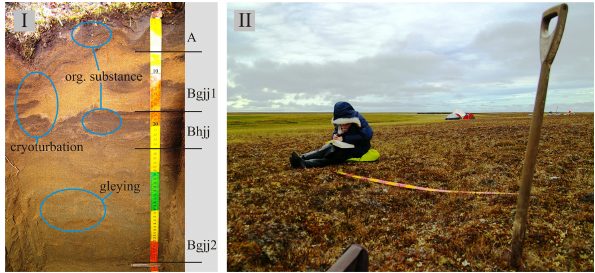
Figure 4. A “sand-dominated and cryoturbated” permafrost- affected soil, Typic Psammoturbel (I) and the study area it is from (II) the Arga Complex, northwestern Lena River Delta, Siberia 2009. Psammoturbel , great group: Psamm(o) from psamm , mean- ing sand; suborder: turb , from Latin turbatio , meaning disturbance; order: el , formative element of Gelisols, from Latin gelu , meaning frost, coldness. “A” and “B” indicate soil horizons. “A” indicates a mineral horizon that has formed at the surface or below an or- ganic horizon. It has accumulated humified organic matter that is mixed with the mineral fraction. “B” indicates subsurface horizons (see Fig. 3). Within this profile there are several B horizons with dif- ferent properties. The suffix “h” indicates an illuvial accumulation of organic matter or sesquioxides and “jj” stands for cryoturbated horizons. Suffix “g” is explained in the caption of Fig.